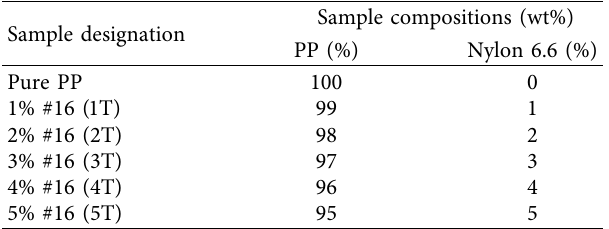
Table 1: Designations and compositions of the studied PP/nylon 6.6